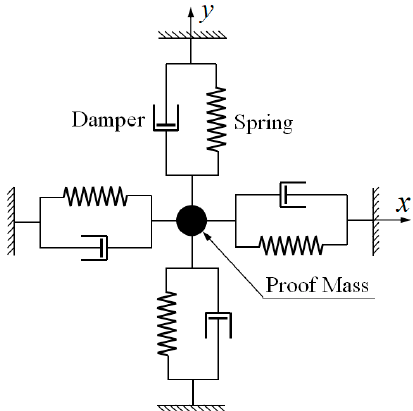
Figure 4. Equivalent mechanical model of ideal hemispherical shell resonator.